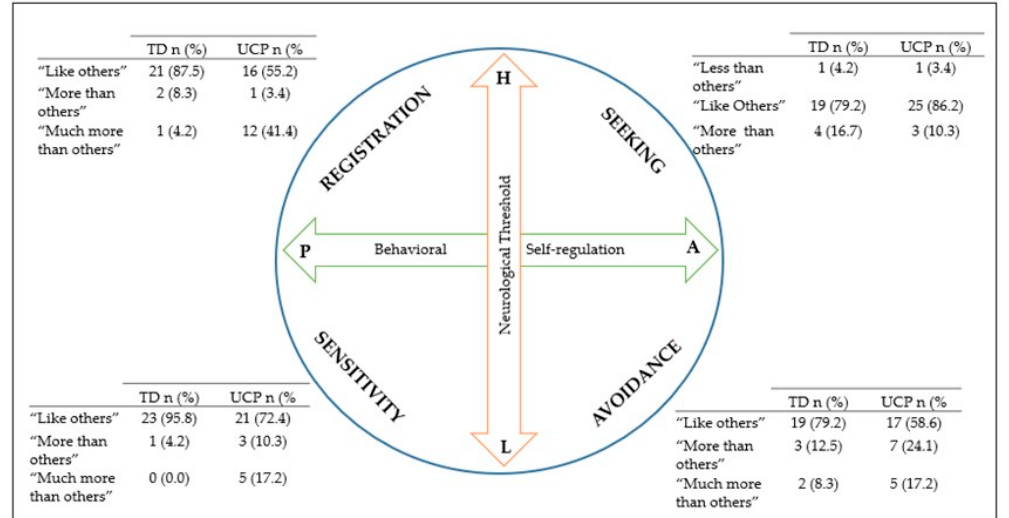
Figure 1. Sensory Profile Patterns distribution in TD and in UCP groups according to the normative data of the Child Sensory Profile 2. “Less than others”: − 1 standard deviation below norm; “Like others”: within norm; “More than others”: + 1 standard deviation above norm; “Much more than others”: + 2 standard deviation above